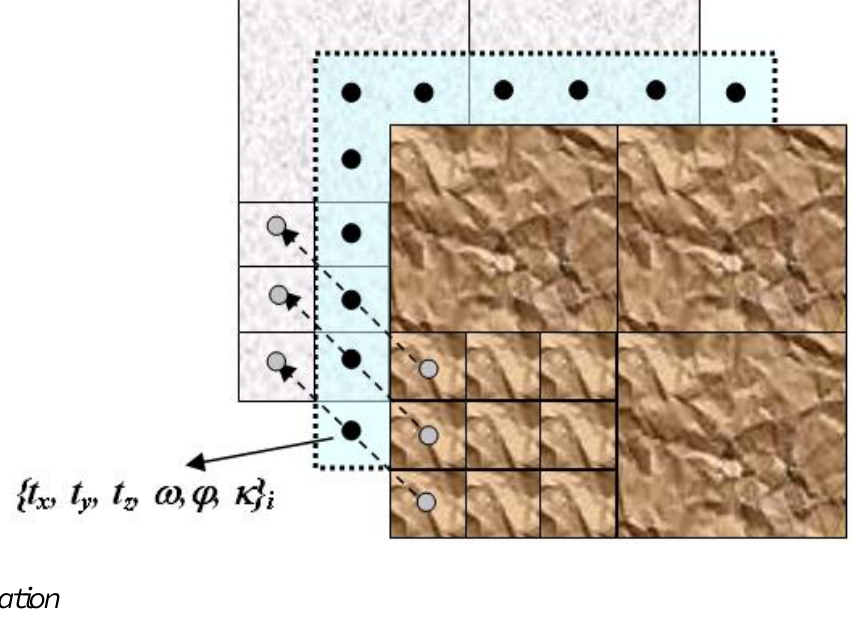
Figure 5. Digital Transformation Parameters Model (DTPM) transformation matrix (middle turquoise); and source and target DTMs (front and background). Each matrix cell ( j ) stores a local six-parameter transformation